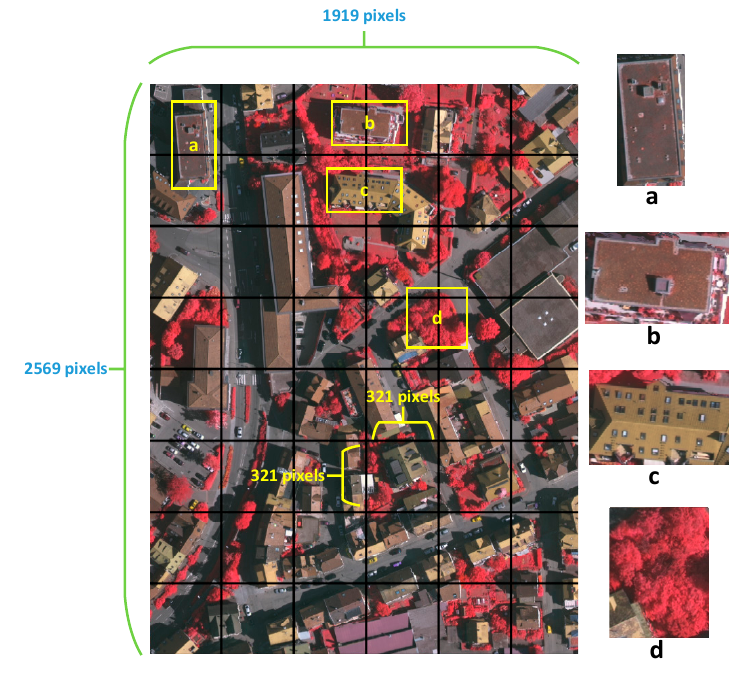
Figure 2. The entire image is cut into multiple patches in the training stage. ( a – d ) The complete labeled objects that could be extracted as supplements of training data.